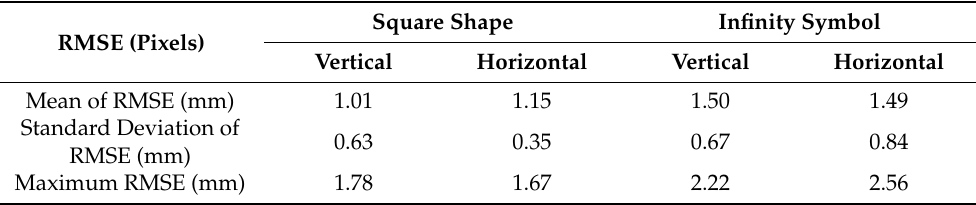
Table 1. Root mean square error (RMSE) of square shape and infinity symbol patterns.